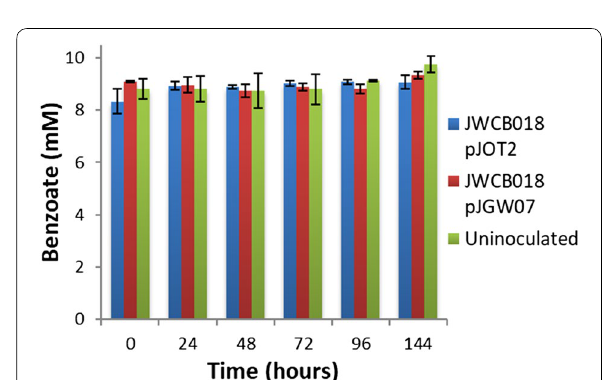
Fig. 4 Growth of C. bescii strains JWCB018 pJOT2 and JWCB018 pJGW07 in defined medium (containing 5 g/L maltose) supplemented with 10 mM sodium benzoate and 80 mM MOPS buffer (initial pH 6.8). Error bars represent the standard deviation = from analysis of 3 replicate cultures